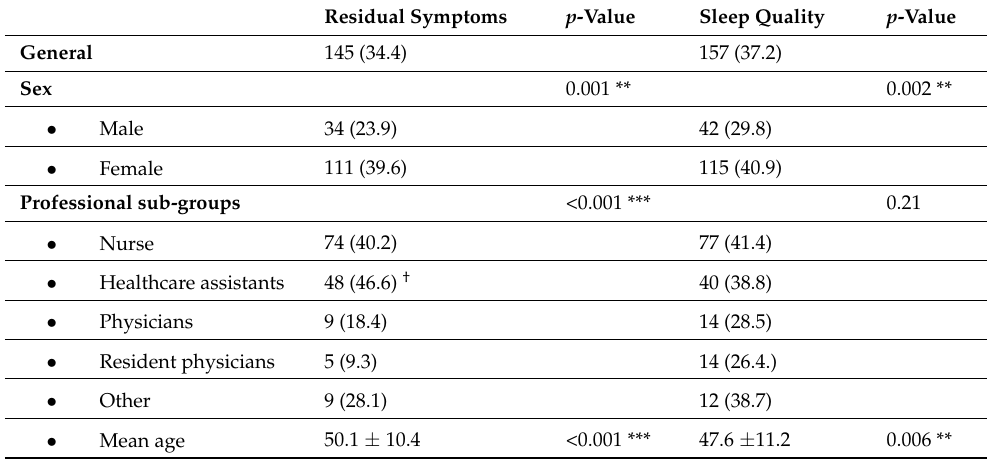
Table 3. Residual symptoms and changes in sleep quality 3 months after SARS-CoV-2 infection.